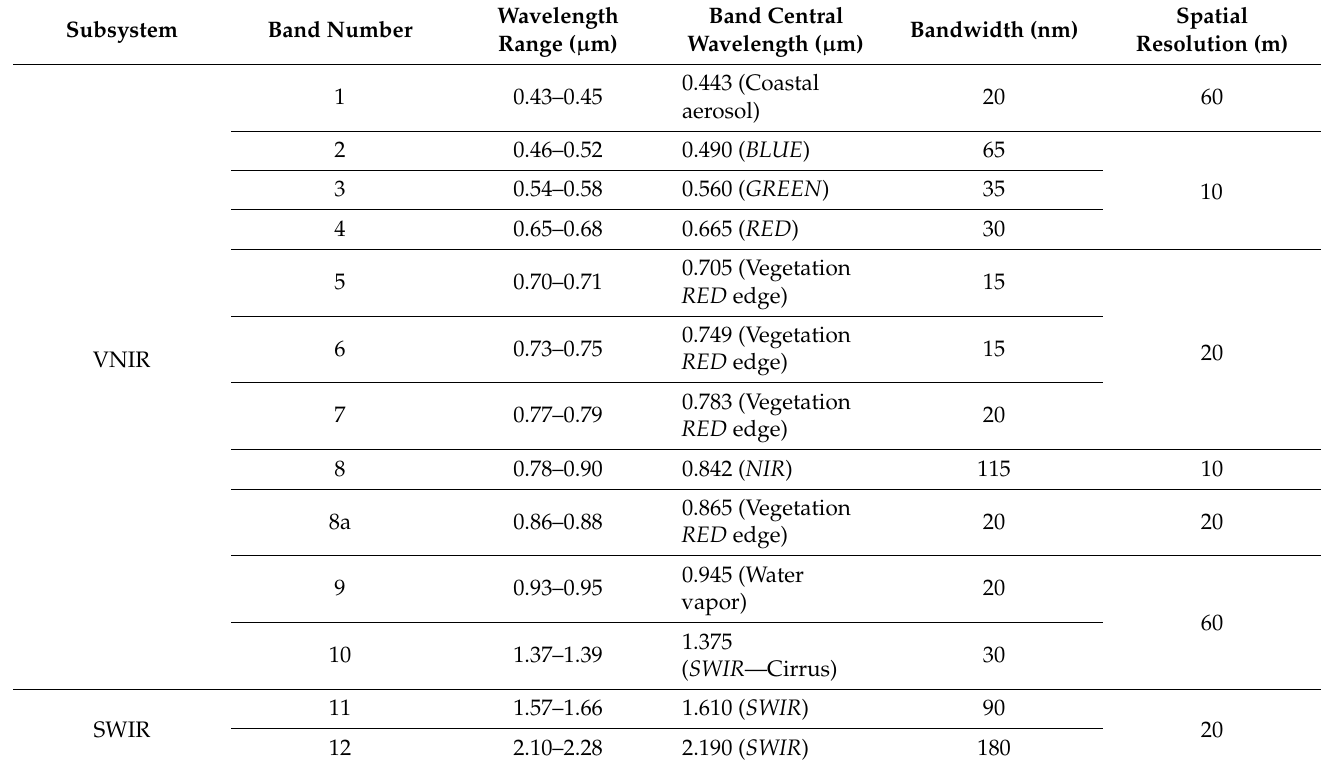
Table 1. Band specification of the Sentinel-2